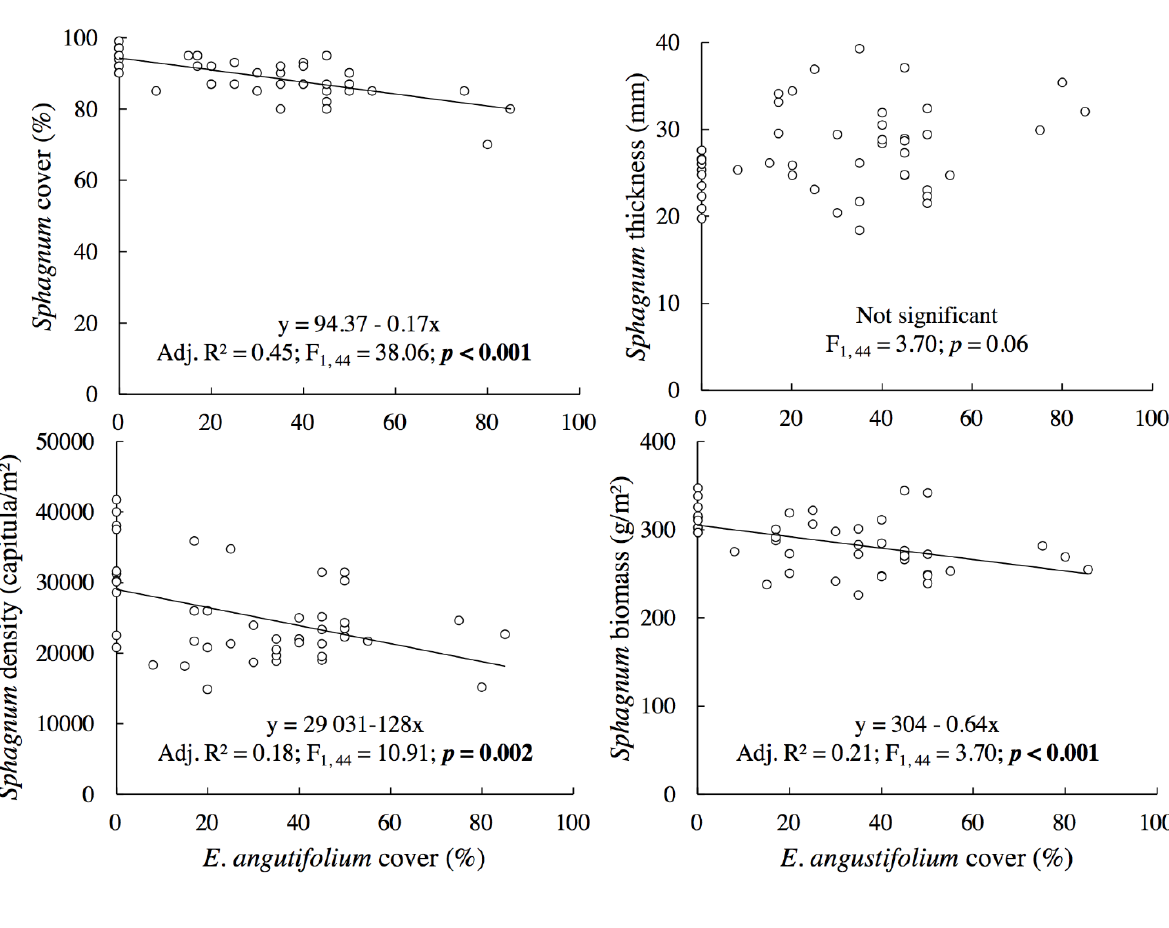
Figure 3. Relations between Sphagnum moss growth metrics (cover, carpet thickness, capitulum density and biomass) and Eriophorum angustifolium cover for the greenhouse experiment. Each point represents a value for an individual experimental unit (n =